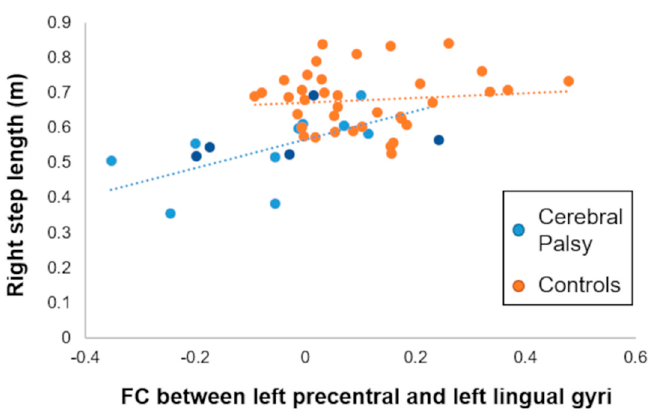
Figure 3. Association between resting-state functional connectivity (FC) and gait biomechanics. Correlation between the FC of the left precentral gyrus (seed) and right lingual cluster and the preferred average right step length. This association was significant in the CP group ( p FDR ≤ 0.05), but not in the neurotypical controls ( p > 0.05). Light blue dots refer to the youth with spastic diplegic presentation, while the dark blue dots refer to the youth with a hemiplegic presentation. This association implies that youth with cerebral palsy who have weaker FC between the motor and occipital cortical areas tend to have a reduced step length.